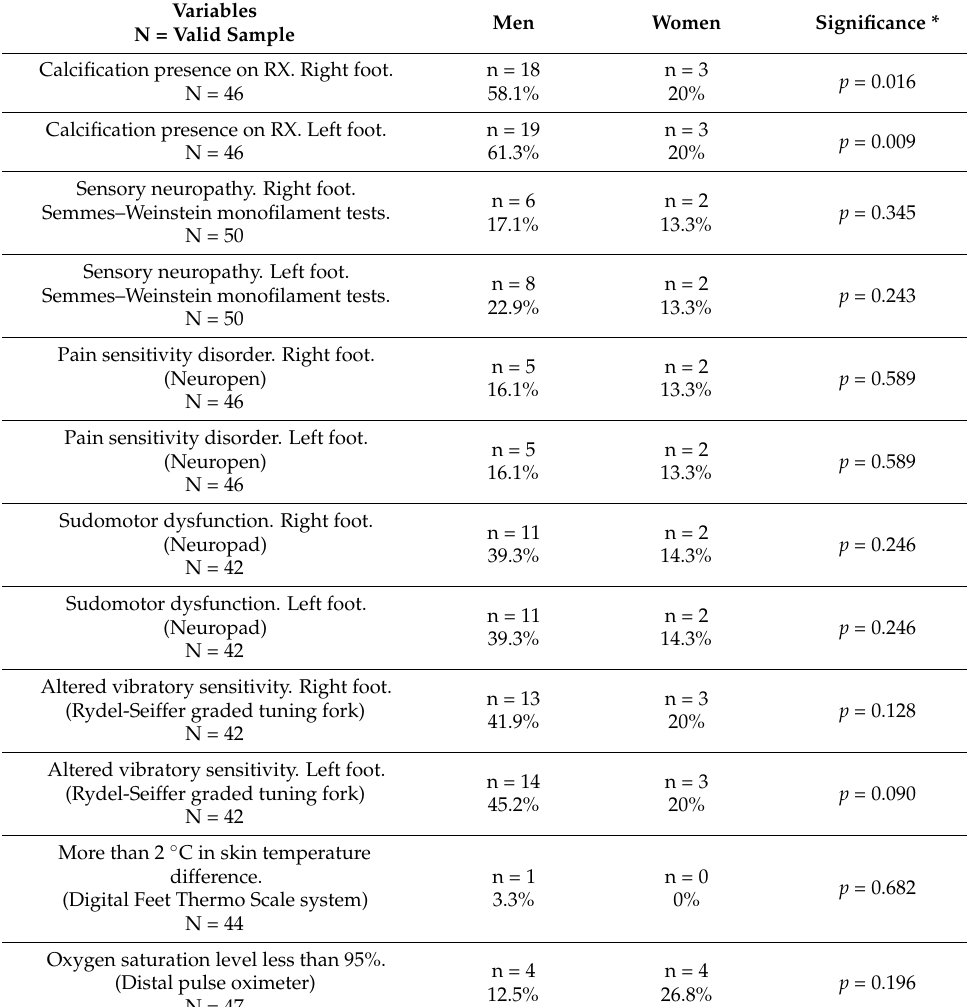
Table 1. Descriptive values and comparison of physical parameters according to gender. Variables Men Women Significance * N = Valid Sample Calcification presence on RX. Right foot. N =